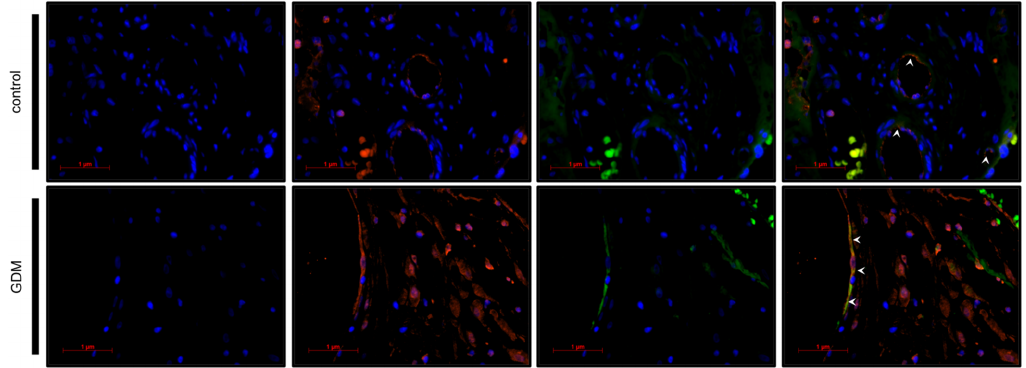
Figure 6. Double immunofluorescence phenotyping of villus cells. Nuclei are stained blue using DAPI. Galectin-2, bound by Cy-3-labled secondary antibody, is stained red. CD31, bound by Cy-2-labeled secondary antibody is stained green, marking fetal endothelial cells. Arrows heads indicate the merging expression of CD31 and galectin-2, visible as yellow. The scale bar equals 1 μm. Microscopic evaluation confirmed CK7 and galectin-2 expression in the same cell, thereby, identifying fetal EVTs as the predominant galectin-2 expressing cell type in the maternal decidua of the GDM, as well as the control group (see Table 1). The galectin-2 expression in GDM placentas appeared to be more intense, compared to the control. Table 1. Quantification of galectin-2 expressing cells. Number of Galectin-2 Positive Cells Evaluated